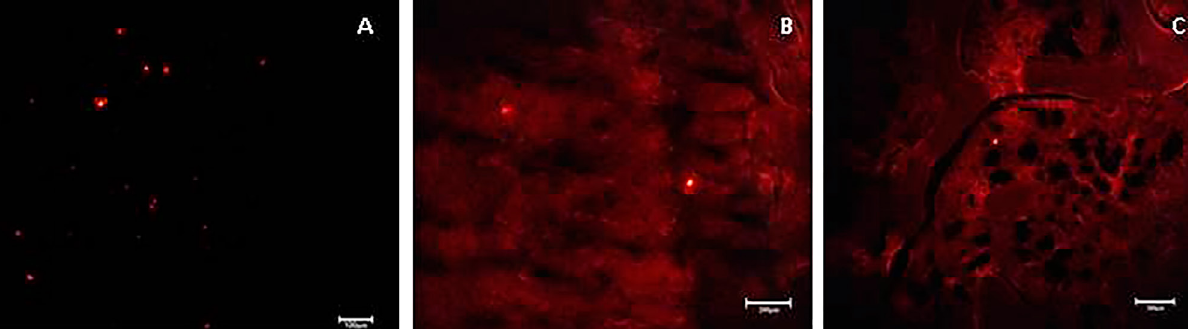
Figure 8- Fluorescence microscopy image, showing (A) positive staining of the hDPSCs using Q-Tracker ® , 100 μm bar; (B) the presence of cells with positive staining using Q-tracker ® in regenerated tissue 30 days after the in vivo transplantation in the group treated with Hemospon ® and hDPSCs, 200 μm bar, and (C) in the group treated with Hemospon ® , hDPSCs and Aloe vera , after 7 days, 200 μm